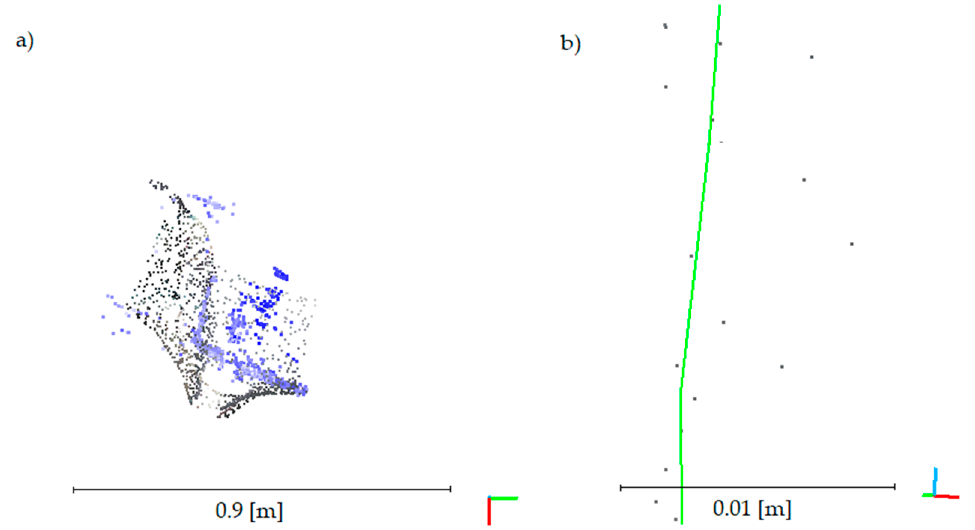
Figure 18 . The differences between models ( a ) differences between laser scanner and photogrammetry on edges. ( b ) Deviation between the contour model and the point cloud, used for modelling